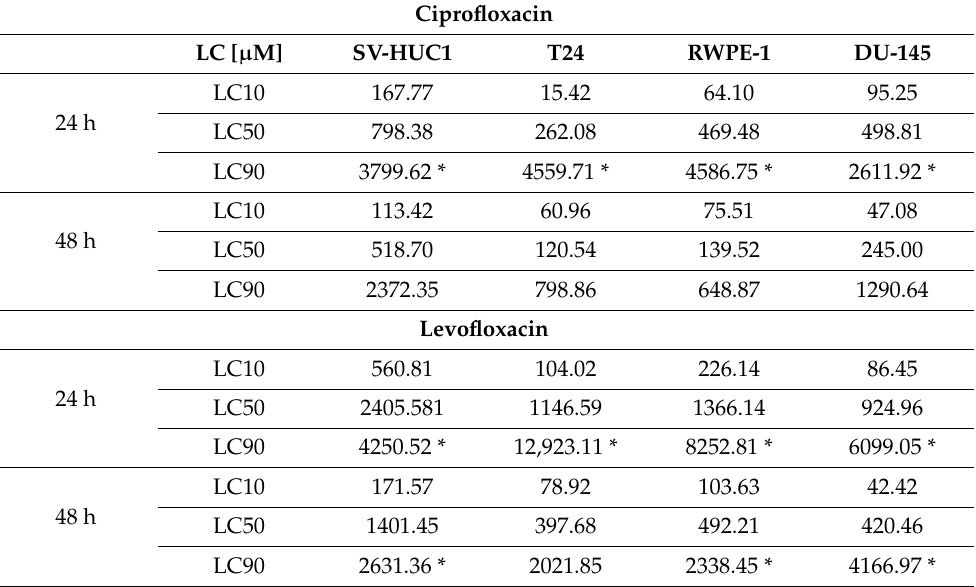
Table 1. Lethal concentrations (LC, µ M values) calculated for ciprofloxacin and levofloxacin after 24 and 48 h incubation with SV-HUC-1 (non-malignant human urothelium), T24 (human bladder cancer), DU-145 (human prostate cancer), and RWPE-1 (non-malignant human prostate epithelium) cell lines. With an asterisk (*), we marked values that were not achieved in MTT assay and were calculated theatrically from the curve equation. Ciprofloxacin LC [ µ